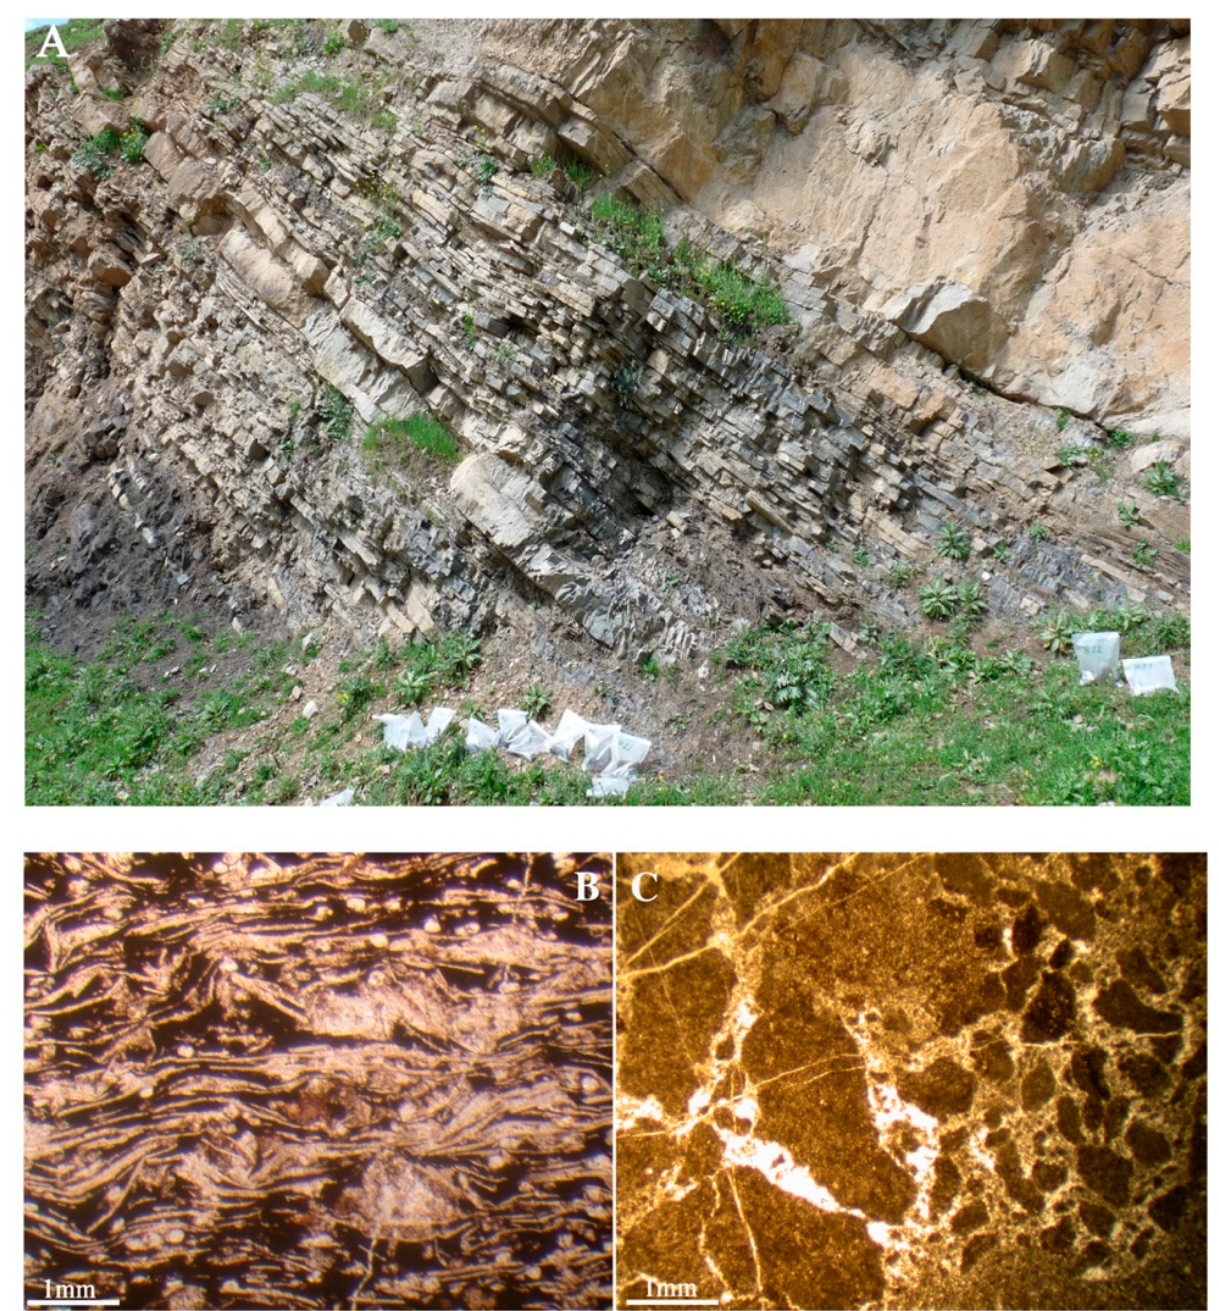
Figure 2. ( A ) Photograph showing the exposed section of the well-bedded limestone deposited during Upper Jurassic, Barsarin formation. ( B ) Photomicrograph illustrates the micro-laminated features of Bositra-like pelecypod shells (see [15]), the micro-laminated features cross-cut by vein of evaporites; ( C ) collapsed mudstone microfacies, giving auto-brecciated sediment. The pore spaces of the breccia are completely occluded by evaporates, with no traces of late diagenetic cements.